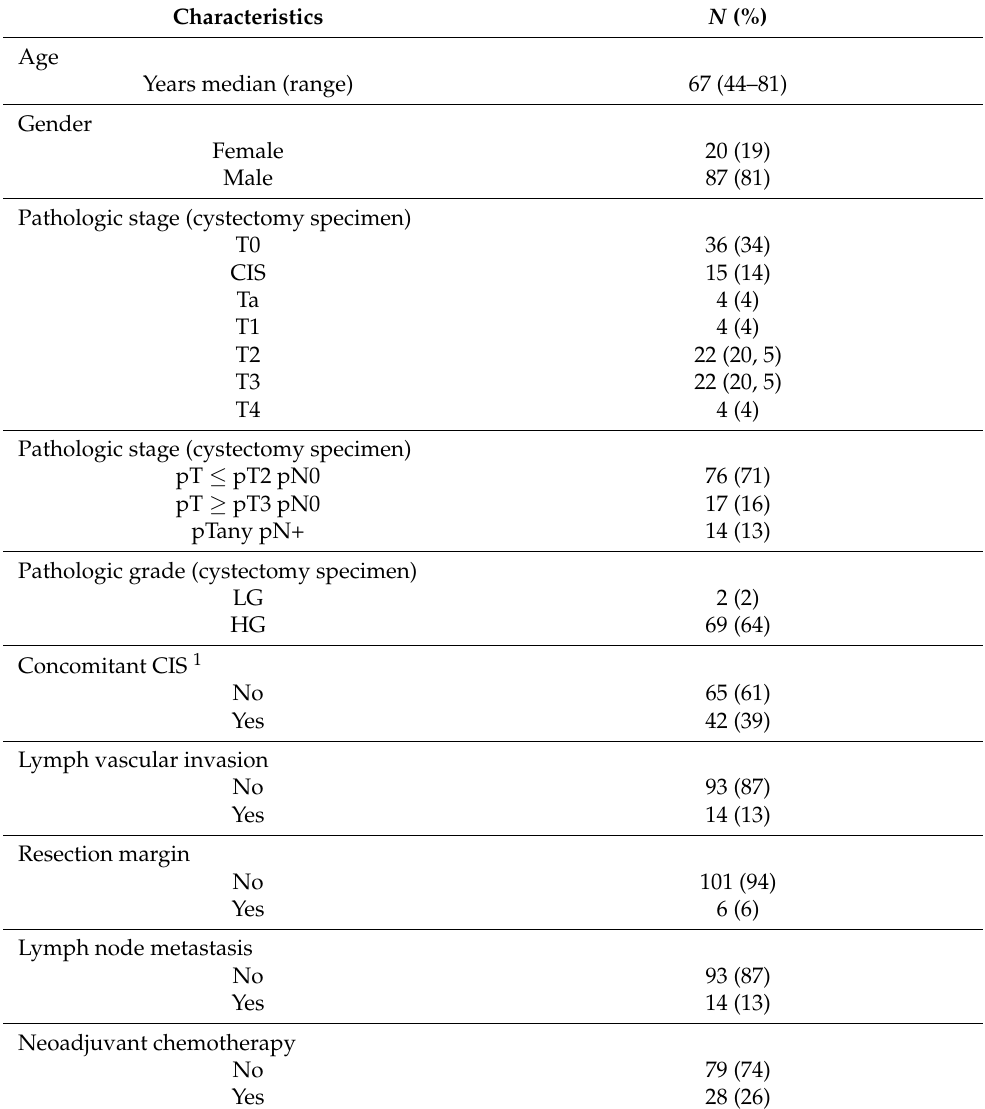
Table 1. Patient characteristics ( n =